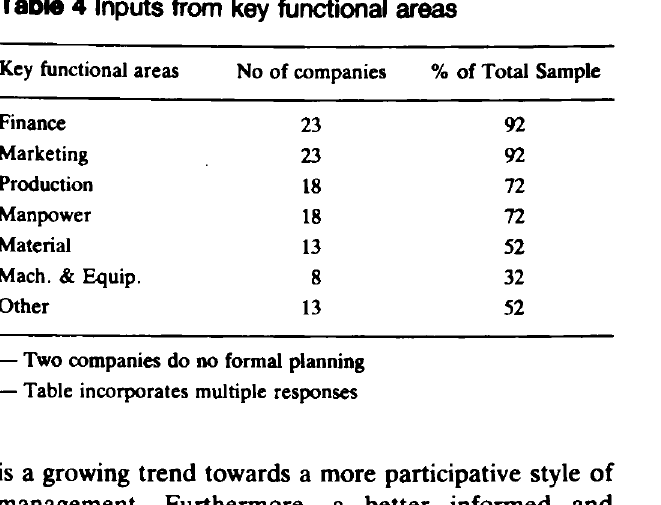
Table 4 Inputs from key functional areas Key functional